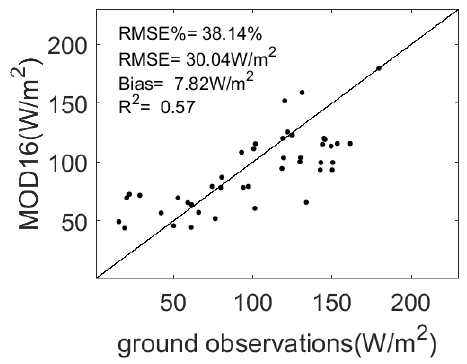
Figure 7. Validation of filled pixels from MOD16 versus ground observations after MKF.